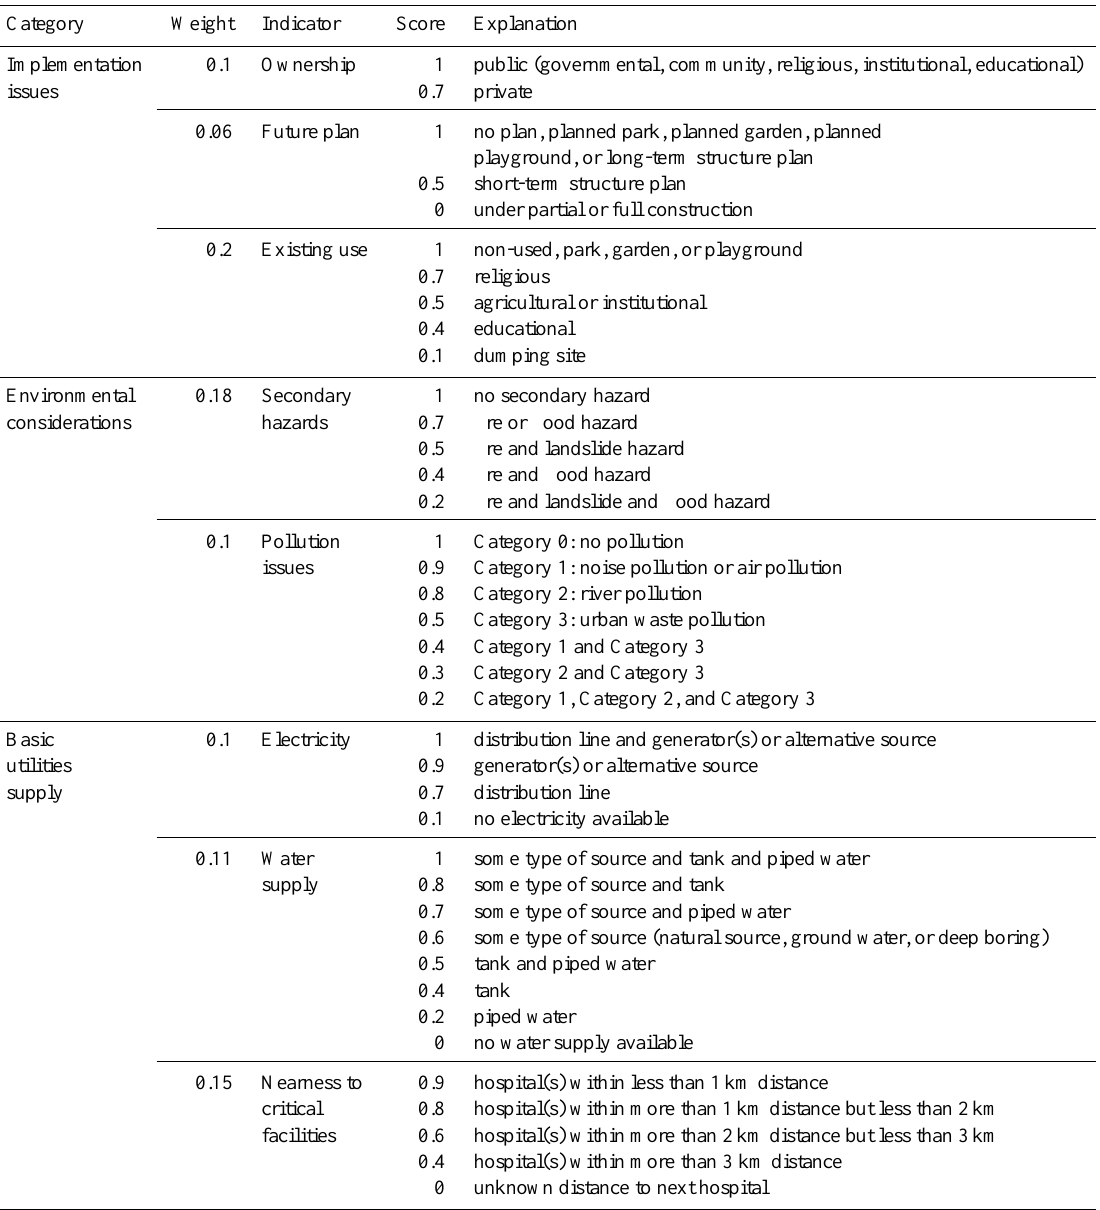
Table 1. Overview of suitability categories and indicator criteria for immediate shelter sites.